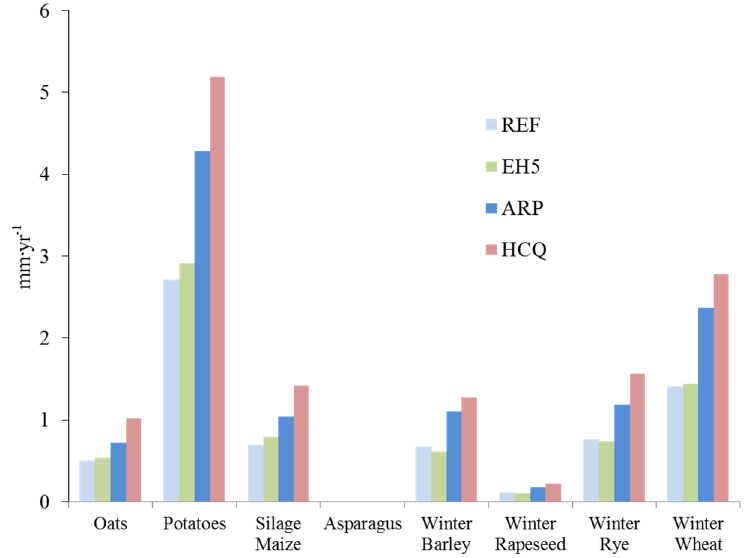
Figure 13. Changes in the average yearly irrigation water deficit through irrigation management scenario SC_II compared to climate projection SC_I for multiple climate projections of the period